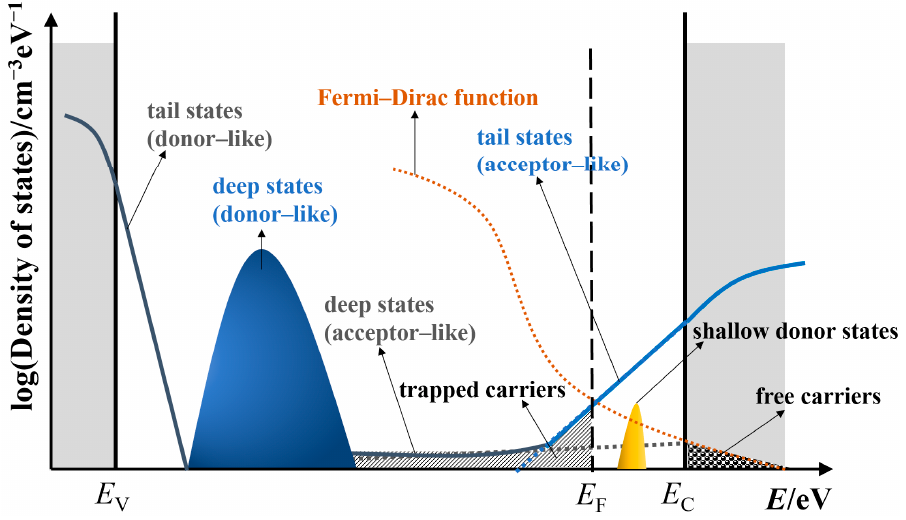
Figure 1. Schematic band diagram of AOS with the distribution of sub-gap density of states.